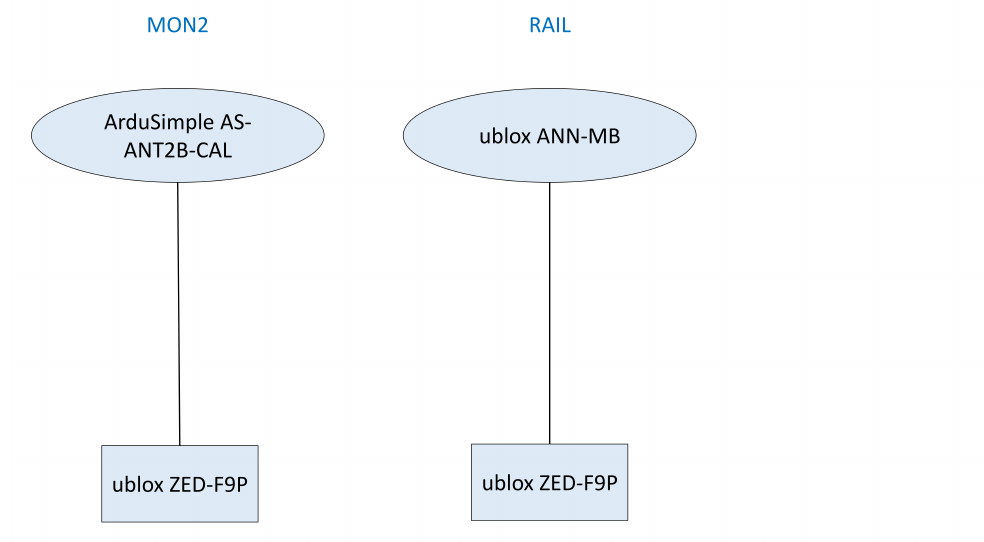
Figure 7. Session 3: receiver and antenna combinations for the experimental